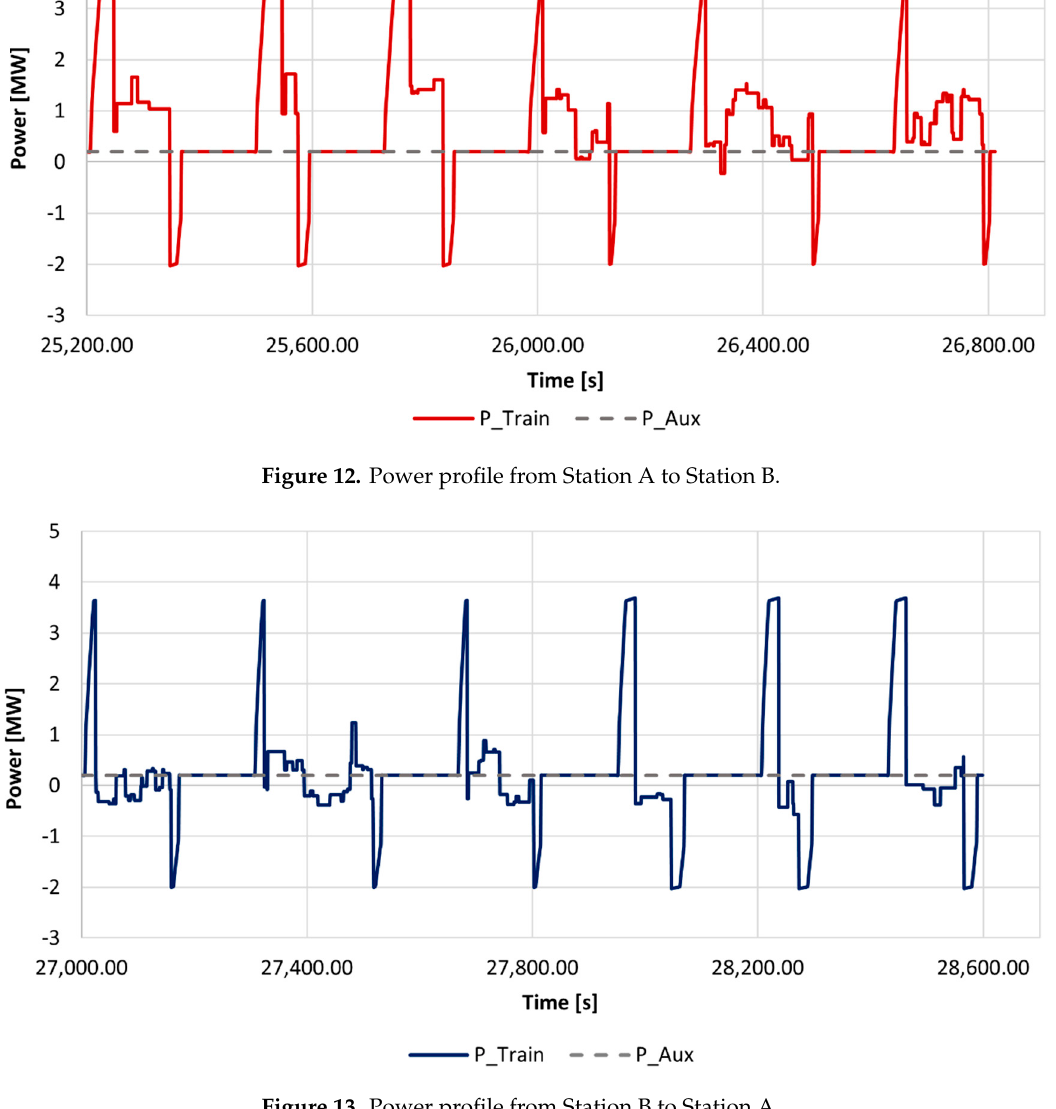
Figure 13. Power profile from Station B to Station A.